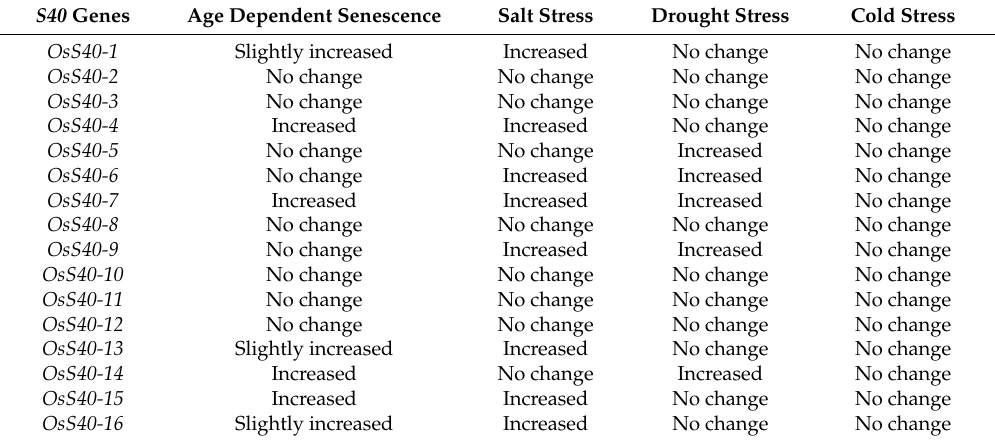
Table 1. Predicted expression level of OsS40 genes under natural and stress-induced senescence (http://bar.utoronto.ca/efprice/cgi-bin/efpWeb.cgi). S40